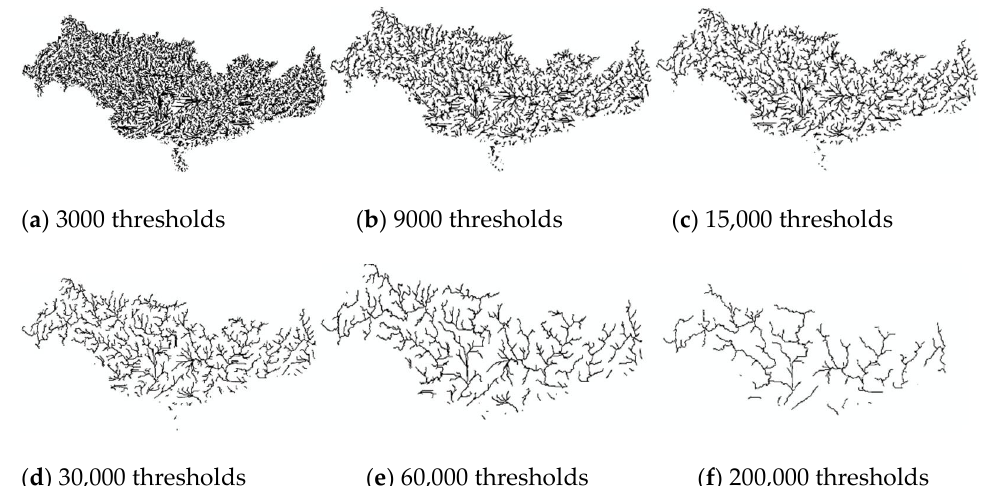
Figure 3. Map of river network under different thresholds of YRB. At thresholds between 3000 and 15,000 ((a) to (c)), the decrease in river network length is not visually significant. At thresholds above 30,000 ((d) to (f)), the river network changes significantly.